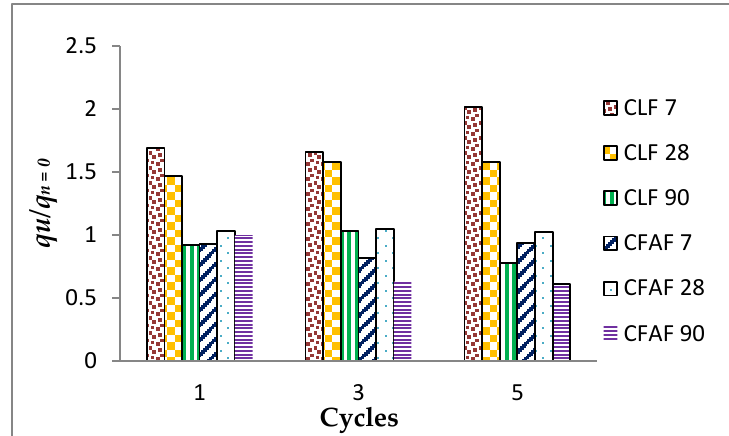
Figure 5. Durability index versus cycles.